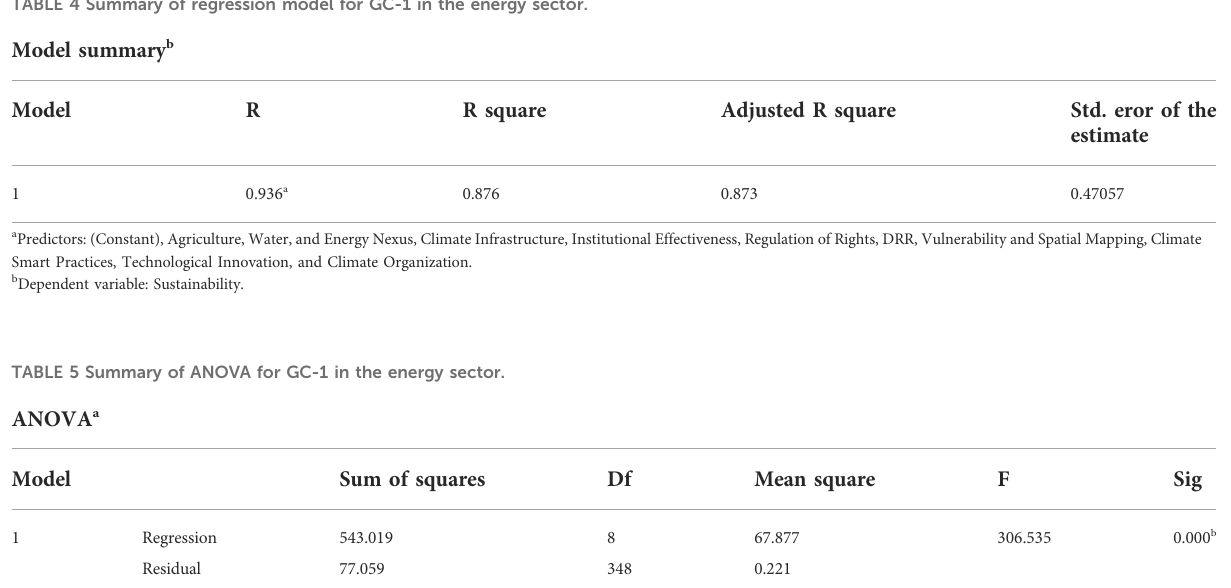
TABLE 4 Summary of regression model for GC-1 in the energy sector.